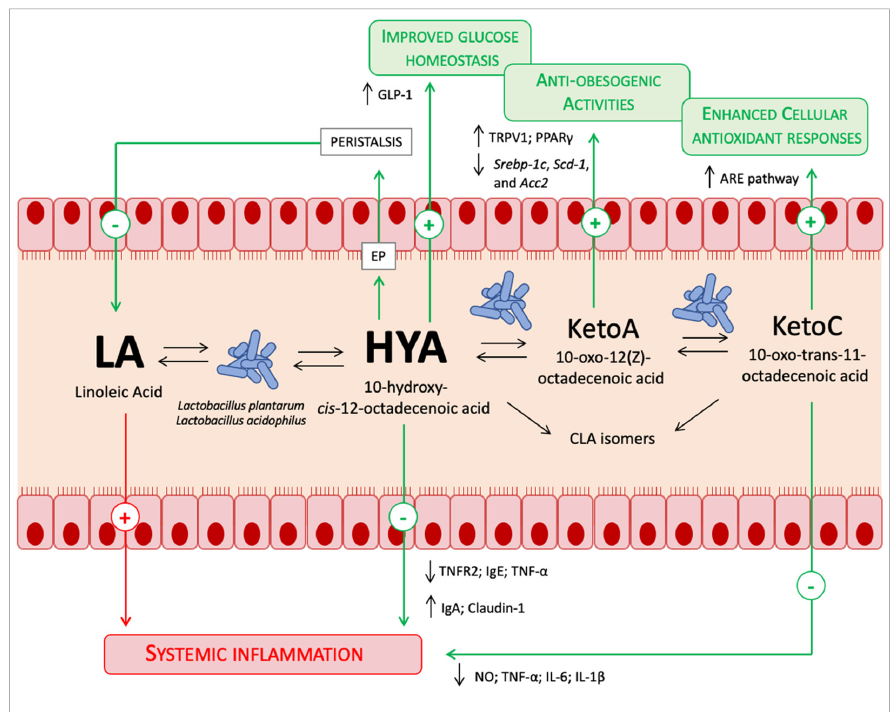
Figure 1. Known prebiotic effects of PUFAs. The font size relative to the PUFAs metabolites is proportional to the quantities found in the gut lumen. See the text for a detailed description.